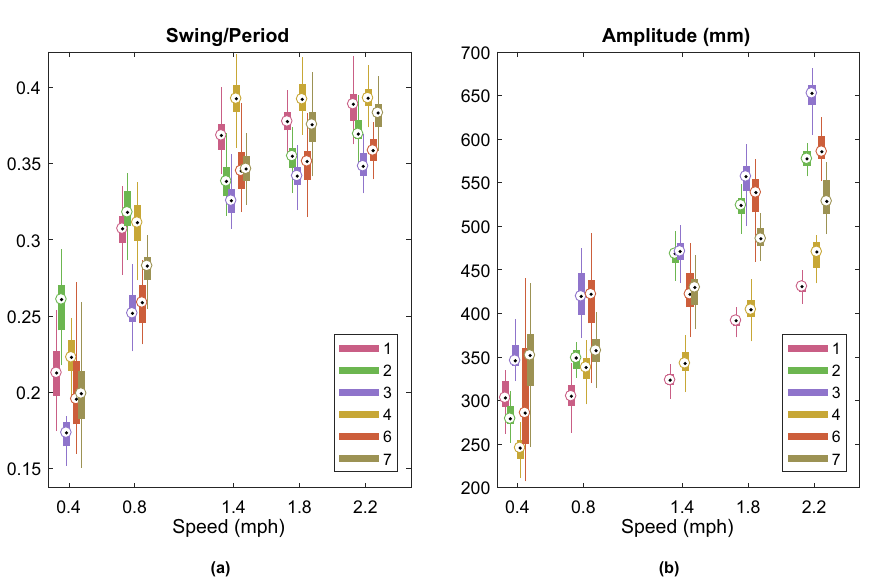
Figure 3. Features from level-ground walking at different speeds, 0.4 mph (0.65 km/h), 0.8 mph (1.29 km/h), 1.4 mph (2.25 km/h), 1.8 mph (2.90 km/h) and 2.2 mph (3.54 km/h), for each subject: ( a ) stride swing/ period ratio; ( b ) step amplitude. Data from Subject 5 was invalid in these trials and therefore not used (see Supplementary Table